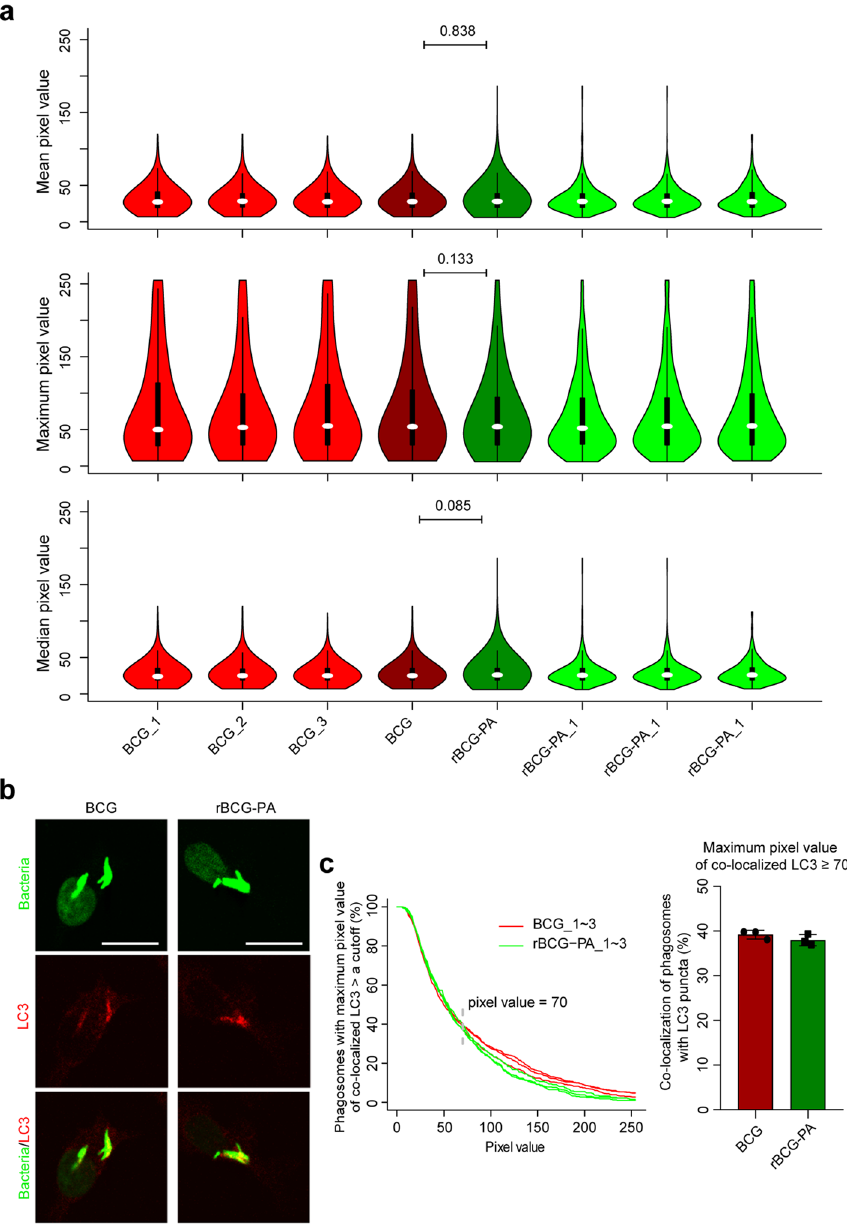
Figure 5. Co-localization of BCG and rBCG-PA strains with LC3 in BMDMs. ( a ) Violin plots of mean (upper panel), maximum (middle panel), or median (lower panel) of LC3 co-localized with phagosomes. BCG_1–3, BCG, rBCG-PA_1–3, and rBCG-PA mean the same as in Fig. 4a. There were at least 200 phagosomes/PVs for each violin plot. ( b ) Representative images depicting the co-localization of BCG and rBCG-PA with LC3 in BMDMs. Scale bars represent 10 μM. ( C ) Cumulative percentages of BCG and rBCG-PA (i.e. phagosomes) that had a corresponding maximum PV of LC3 larger than a cutoff value (left panel) or larger than 70 (right panel). P values are marked for differences between BCG and rBCG-PA; one-way ANOVA with Tukey’s multiple comparisons test for ( a